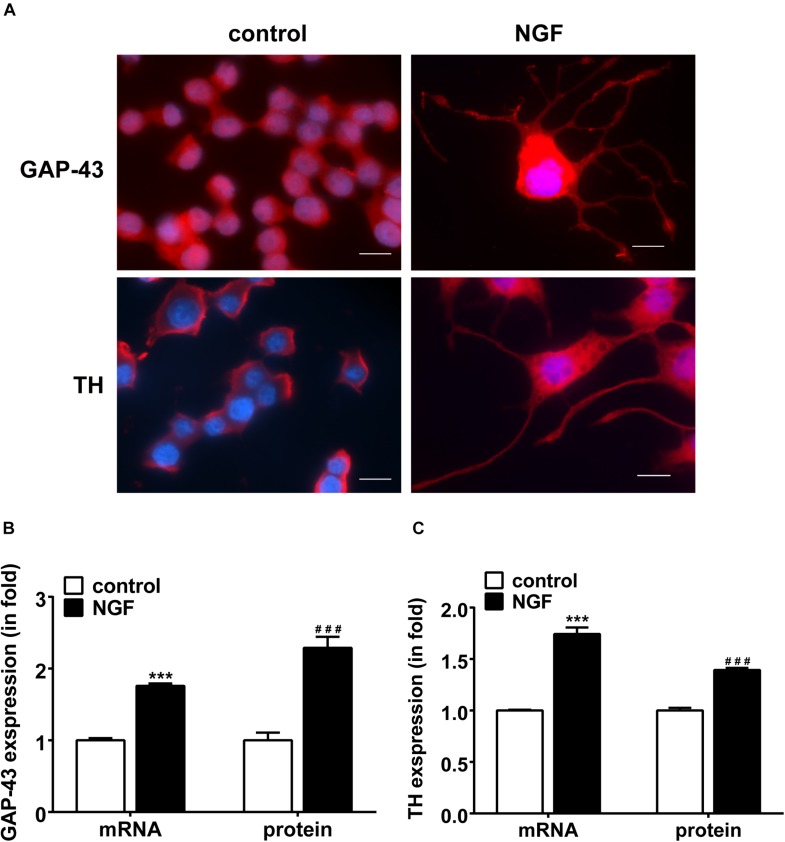
NGF-induced PC12 cell differentiation toward sympathetic neurons and expressions of GAP-43 and TH. (A) Immunofluorescent stains of GAP-43 (red, upper row) and TH (red, lower row). Nuclei were stained blue by DAPI. Note that NGF induced significant neurite outgrowth. Scale bar, 10 μm. (B,C) Real-time PCR and western blotting results of GAP-43 and TH expressions in PC12 cells treated or untreated with NGF. ∗∗∗p < 0.001 vs. respective control. ###p < 0.001 vs. respective control; n = 3 for each value.